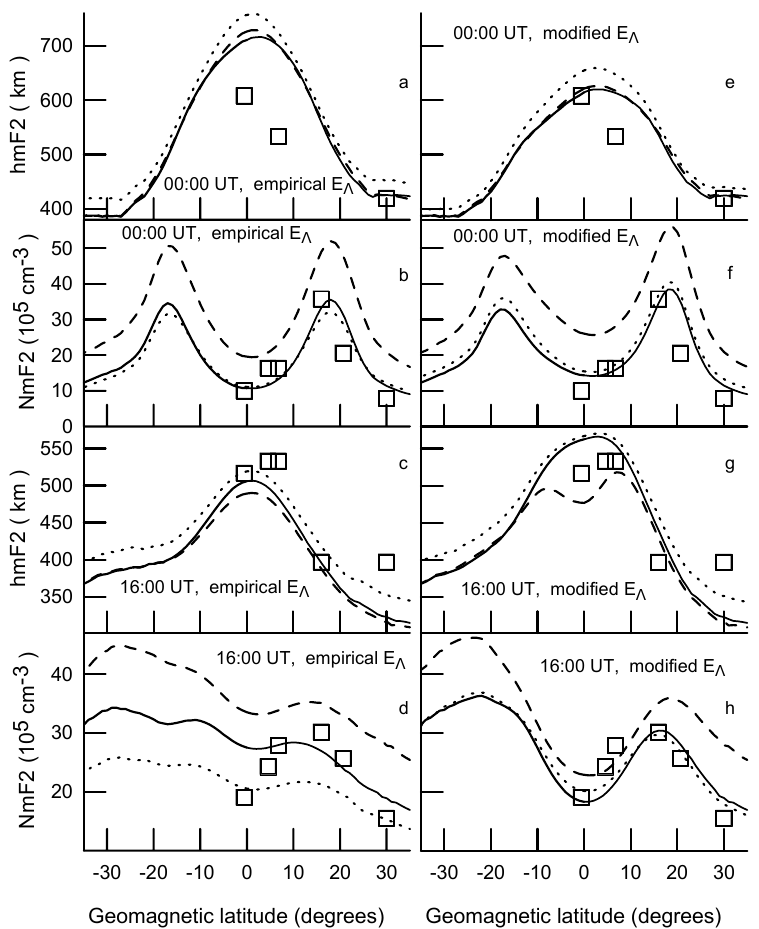
Fig. 2. Observed (squares) and calculated (lines) hm F2 and Nm F2 at 00:00 UT (Panels a , b , e , f ) and 16:00 UT (Panels c, d, g, h ) on 7 October 1957. Left panels (a), (b), (c), (d) show the model results when the original equatorial perpendicular plasma drift of Scherliess and Fejer (1999) given by the dash-dotted line in Fig. 1 is used. Right panels (e), (f), (g), (h) show the model results when the empirical equatorial electric field found the equatorial perpendicular plasma drift velocity of Scherliess and Fejer (1999) was modified in the time range between 07:27 LT and 11:00 LT and between 15:00 LT and 18:30 LT (this modified equatorial electric field is shown by a solid line in Fig. 1). Dashed lines show the model results when the original NRLMSISE-00 neutral temperature and densities are used. Solid lines show the model results when the NRLMSISE-00 model [O] was decreased by a factor of 1.7 from 16:12 UT to 23:12 UT (from 11:00 LT to 18:00 LT, where LT is the local time at the geomagnetic equator and 351.9 ◦ of the geomagnetic longitude) during all model simulation period. Dotted lines show the model results when the NRLMSISE-00 model [N 2 ] and [O 2 ] were increased by a factor of 2.1 from 16:12 UT to 23:12 UT during all model simulation period. The vibrationally excited N 2 ( v > 0) and O 2 ( v > 0) are included in the model and the EUVAC solar flux model is used as the input model parameter in all model calculations presented in Fig. 2. The difference between UT and the local time at the geomagnetic equator is